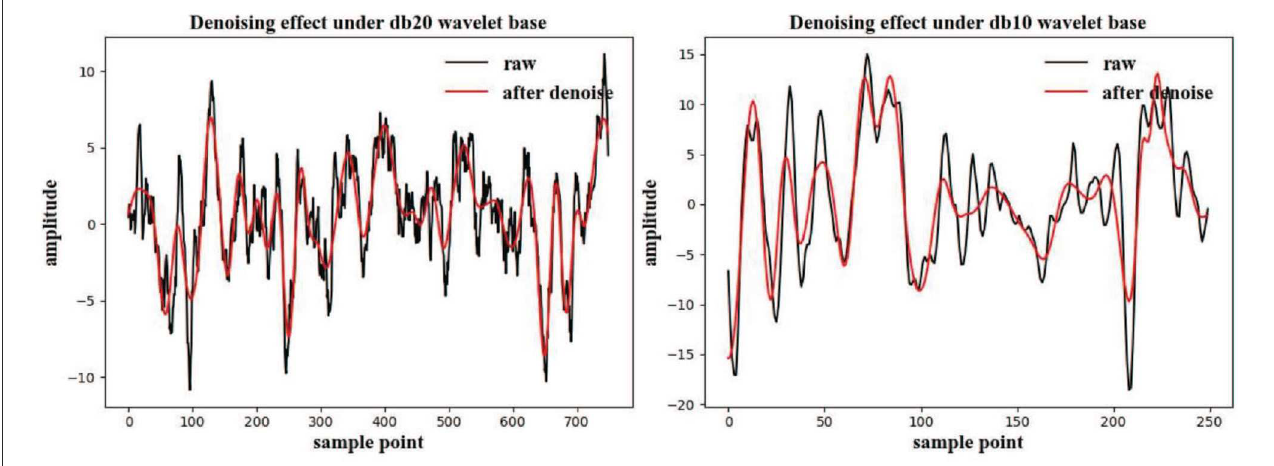
FIGURE4 Wavelet soft threshold denoising results under different competition datasets. The black line in the figure represents the original signal, and the red line represents the result after the wavelet-based denoising.